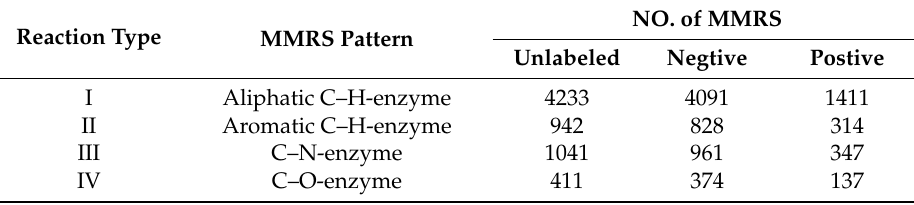
Table 5. Descriptive statistics of MMRS datasets used for